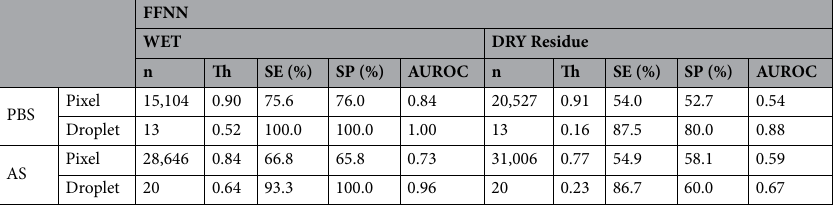
Table 2. Classification performance of the FFNN algorithm. Here, n is the sample size of the test set, Th is the value of the classification threshold, SE denotes the sensitivity, SP is the specificity, and AUROC is the area under the receiver operating characteristic curve.